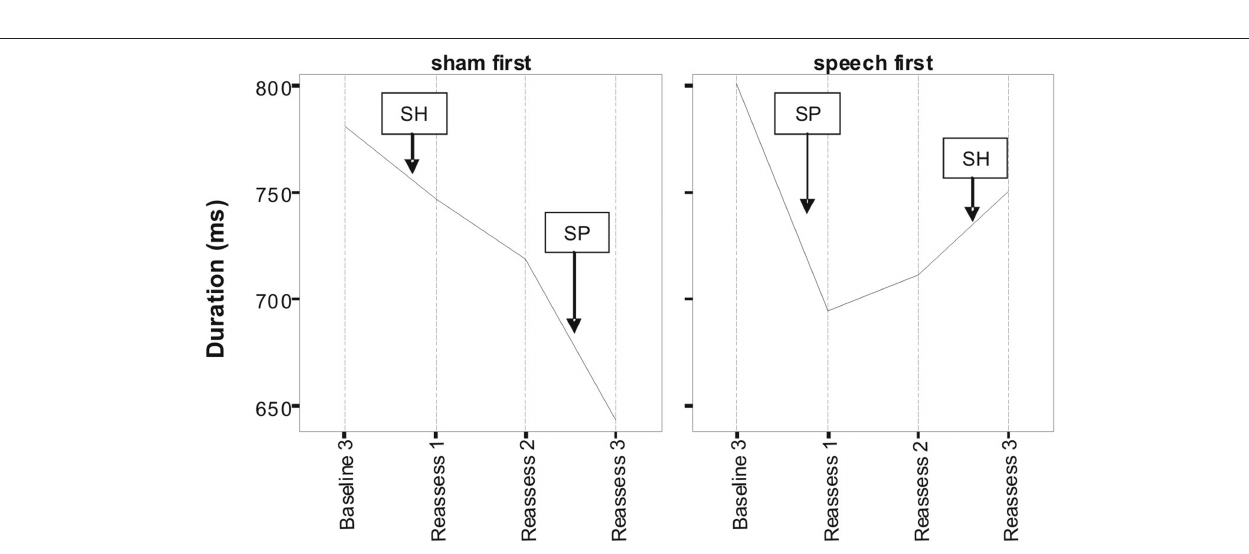
FiguRE 2 | Lexical duration scores as a function of speech treatment (SP) and sham treatment (SH) for the two phase conditions defined as Sham First and Speech First. Data are for treated items (see Pilot Data for additional details).